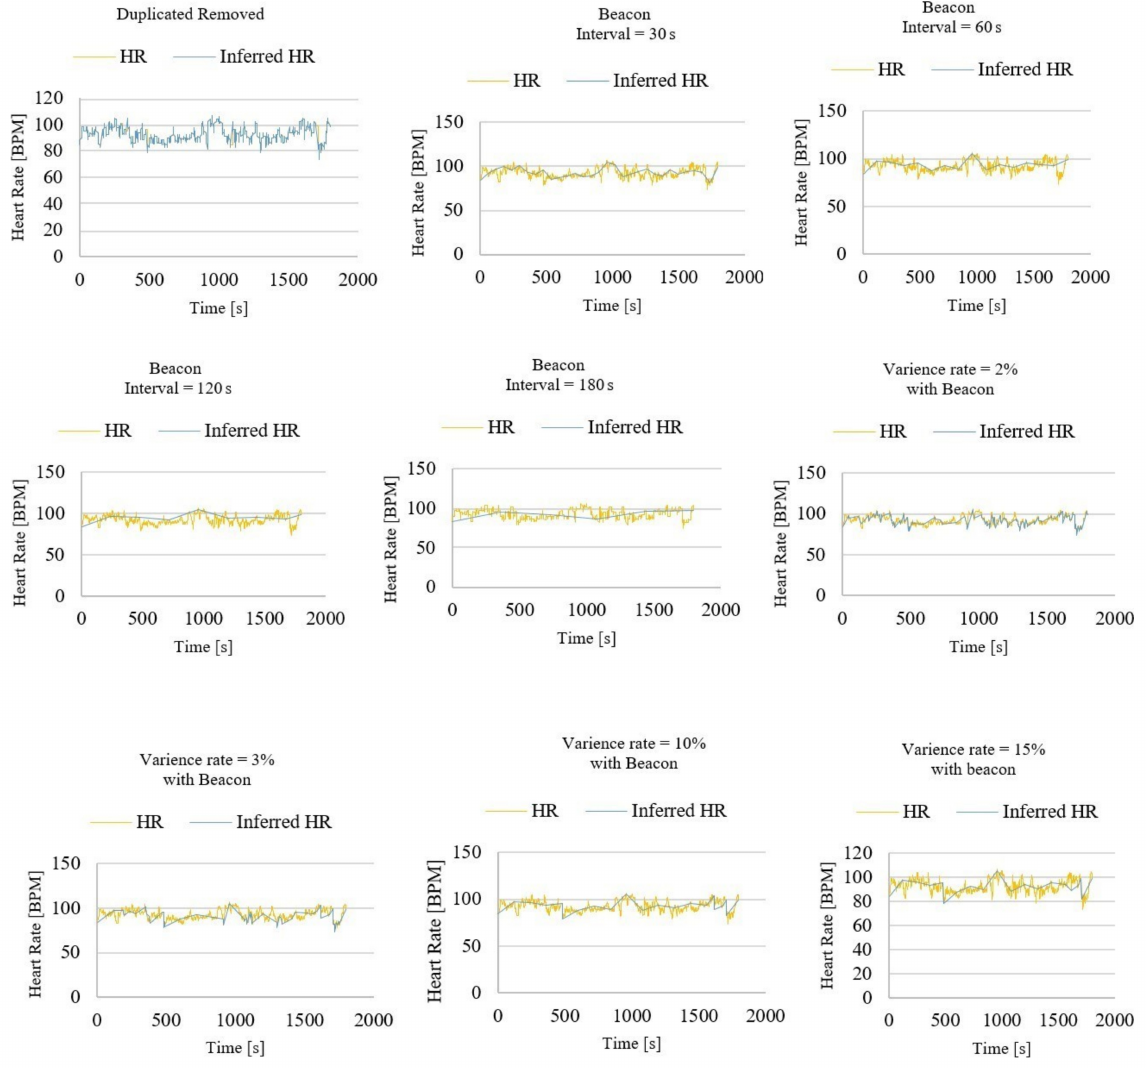
Figure 4. Evaluation of data inference framework (case 1 to case